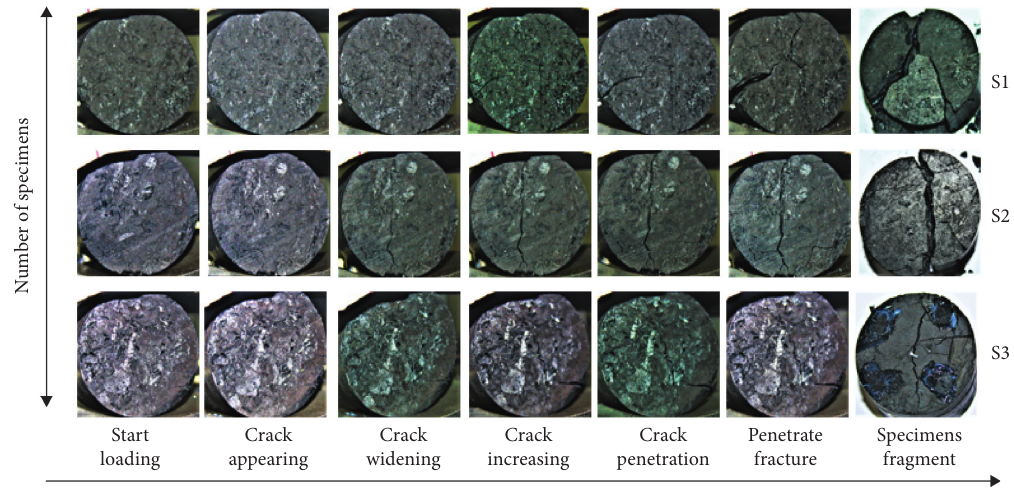
Figure 3: Typical static tensile crack initiation and propagation